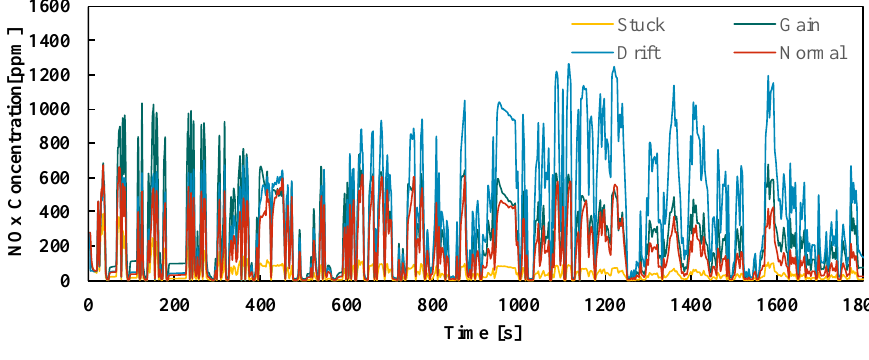
Figure 7. Fault-tolerant control strategy of SCR system.